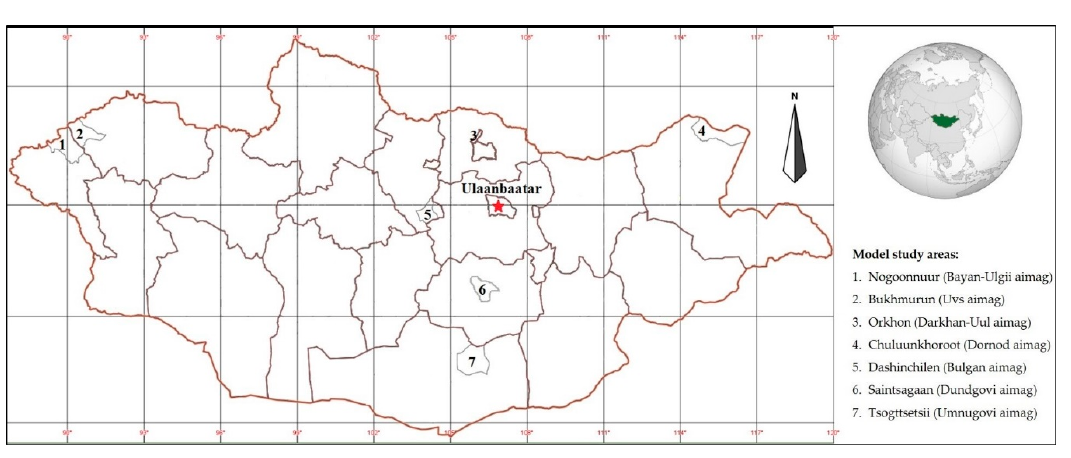
Figure 1. Overview map of the model study areas in Mongolia.